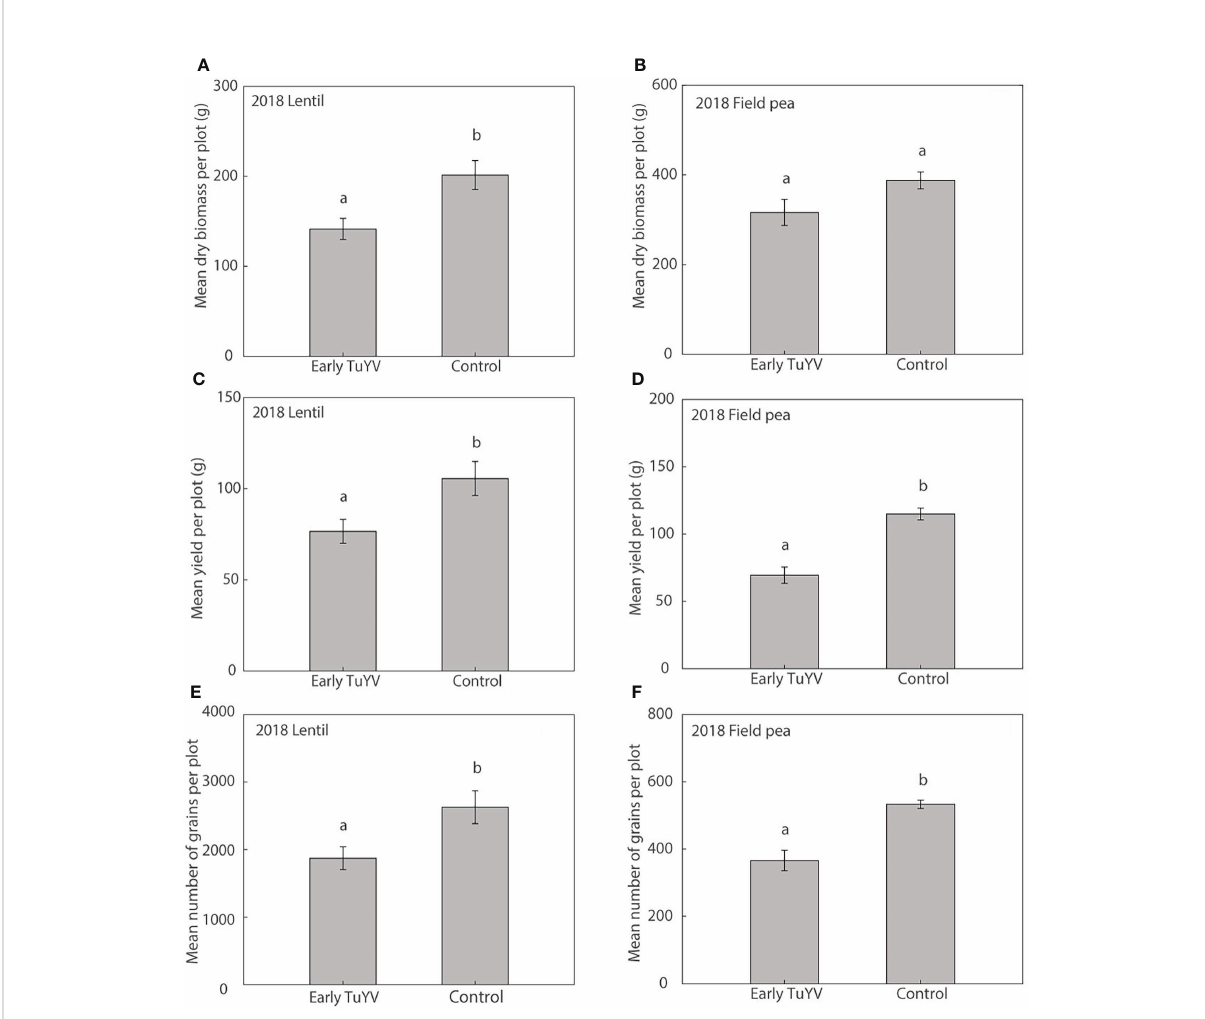
FIGURE 3 The effect of early turnip yellows virus (TuYV) infection on dry plant biomass (A, B) , grain yield (C, D) and number of grains (E, F) of lentil (left) and fi eld pea (right) in fi eld experiments (2018) in south-eastern Australia. Standard errors are represented by error bars; means with different letters are signi fi cantly different at p < 0.05 according to